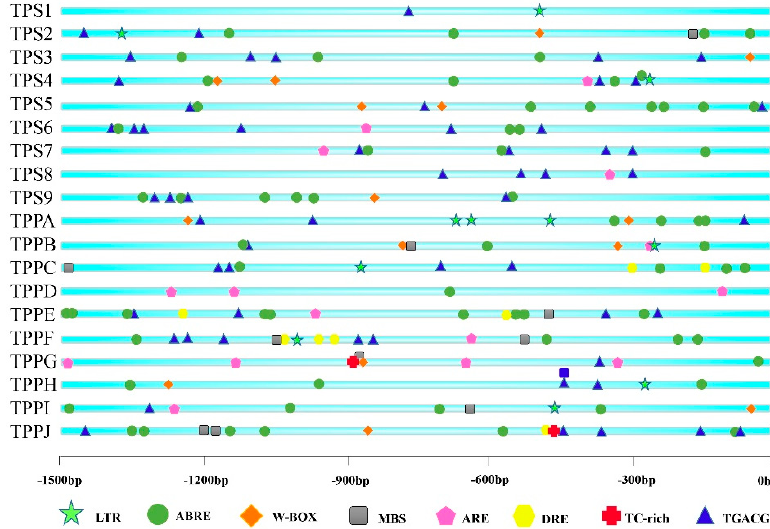
Figure 4. Predicted cis -elements related to stress resistance in the BdTPS / BdTPP promoters. Promoter sequences ( − 1500 bp) of 19 genes were analyzed using the PlantCARE database. The different colors and shapes of markers represent various cis -elements.